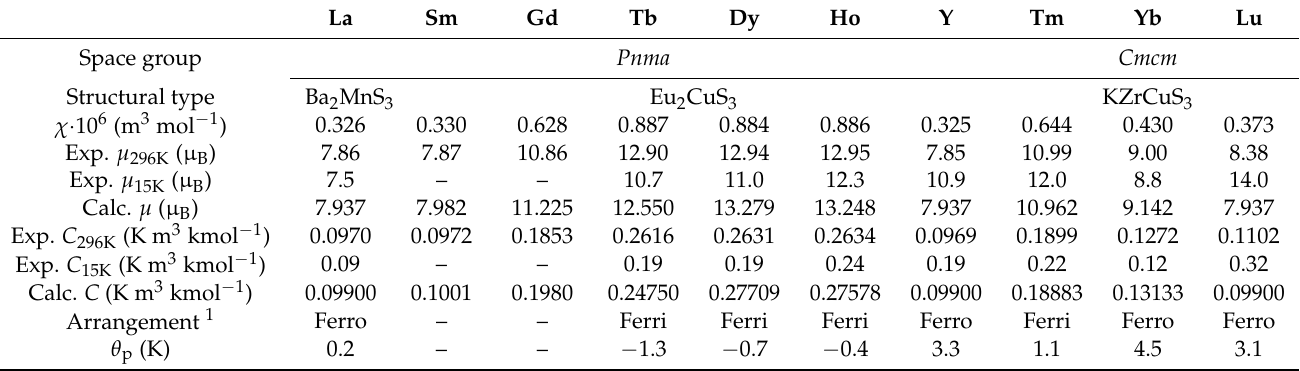
Figure 10. Field-dependent magnetic moments at 296 K ( left ), and temperature-dependent specific magnetization (middle) and reciprocal magnetic susceptibility ( right ) of EuTmCuSe 3 ( top row ), EuLaCuSe 3 ( middle row ) and EuHoCuSe 3 ( bottom row ), respectively, at 10 Oe. The measurements of low-temperature magnetization were performed in the zero-field cooled (ZFC) and nonzero-field cooled (FC) modes. Fit line shows approximation by the Néel model of a ferrimagnet [80]. The calculated values of μ and C for EuYCuSe 3 , EuLaCuSe 3 and EuLuCuSe 3 are the Table 3. Magnetic characteristics for EuLnCuSe 3 (Ln = La, Sm, Gd, Tb, Dy, Ho, Y, Er, Tm, Yb,